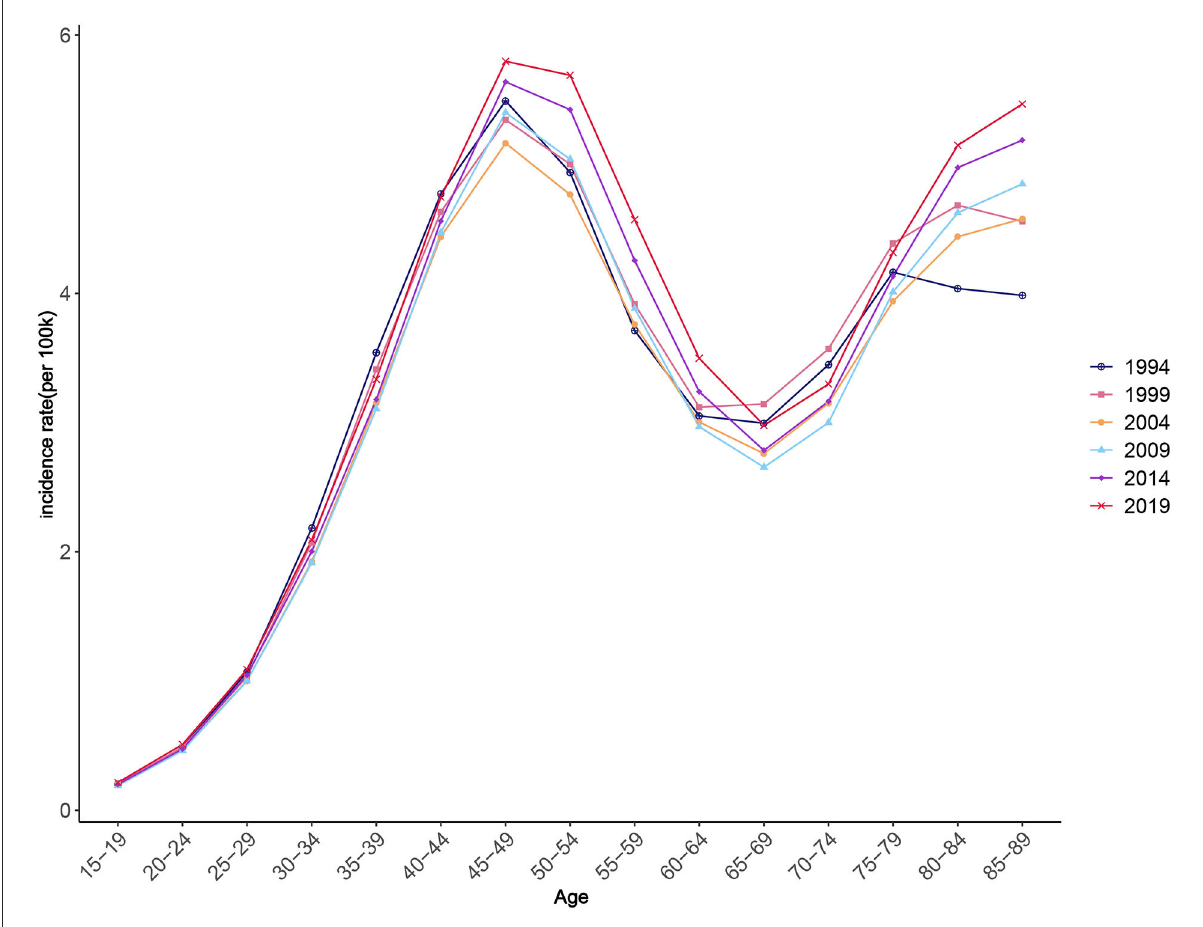
FIGURE6 Age trends in NAFLD